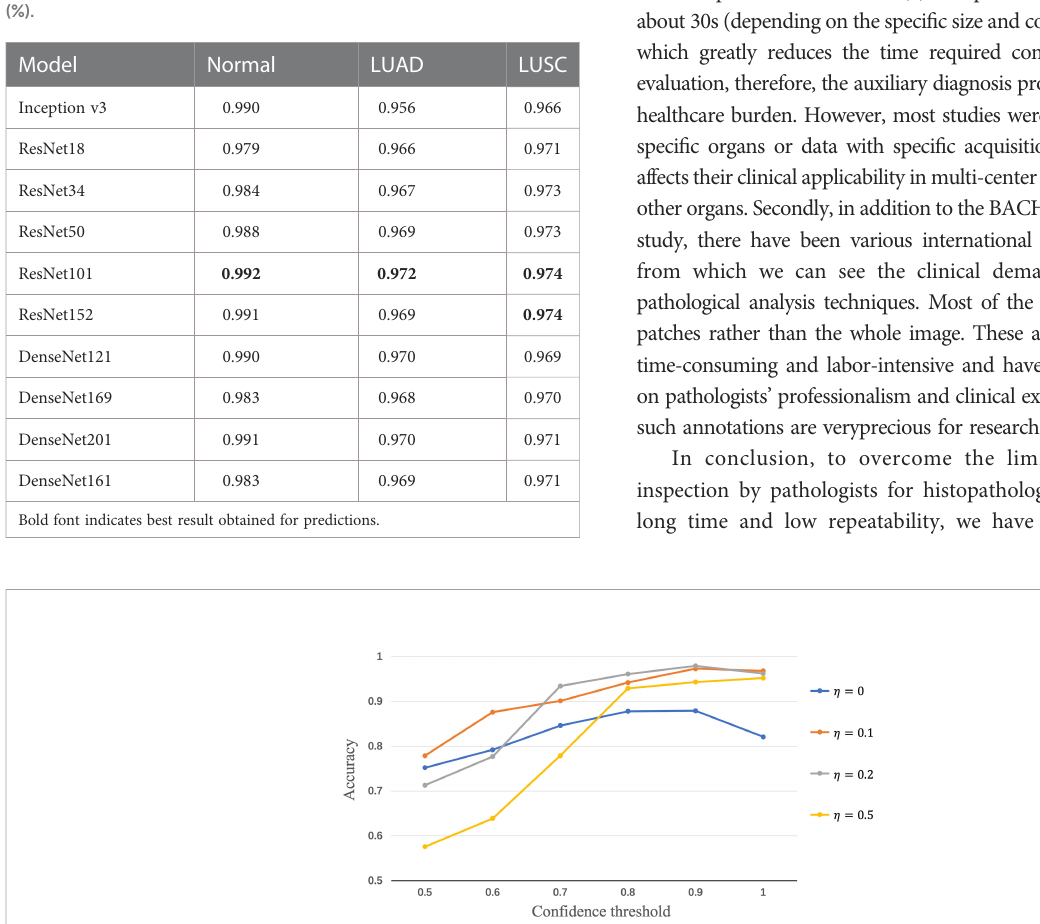
FIGURE 6 Measuring the effect of varying the con fi dence threshold values h and q .